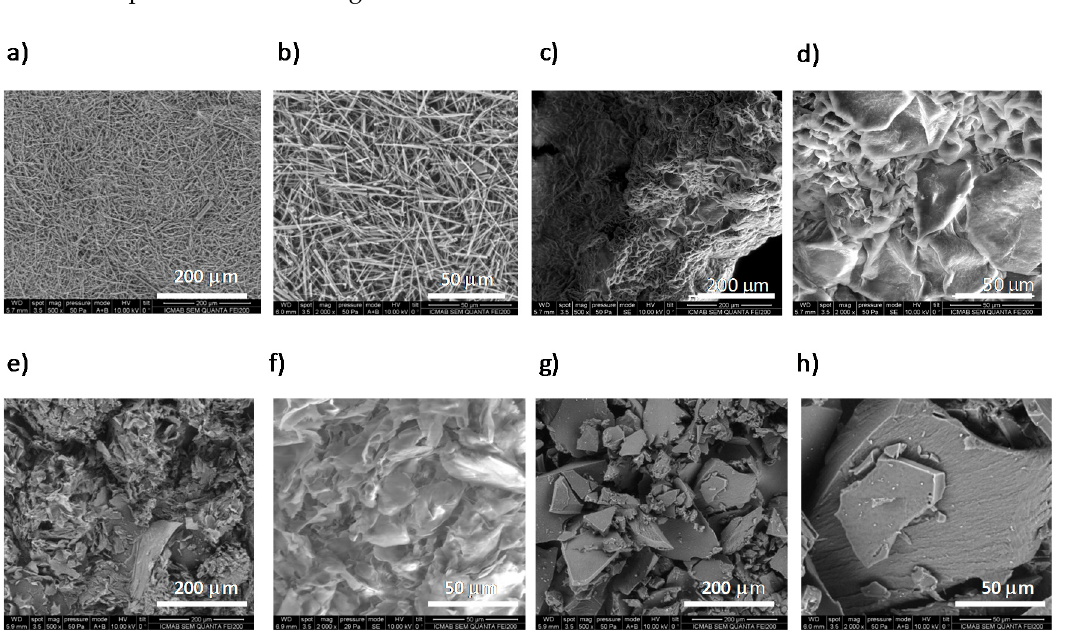
Figure 3. SEM images of xerogels at the mgc of: ( a , b ) cis - 2 from methanol; ( c , d ) trans - 2 from methanol; ( e , f ) 4 from acetone; ( g , h ) 4 from pentane, at two magnifications each (200 and 50 μ m).